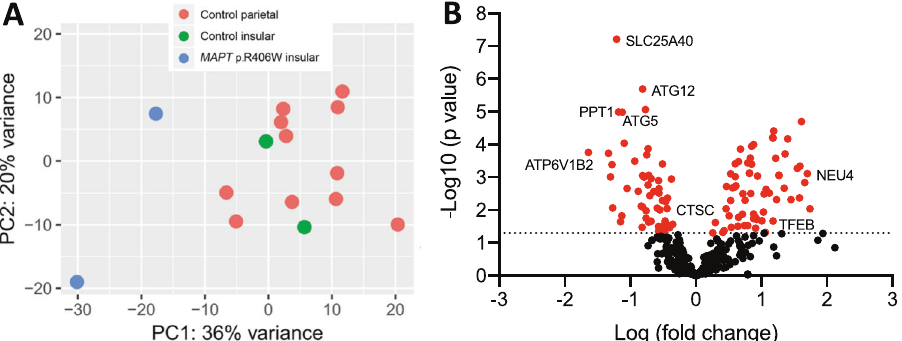
Fig. 1 TFEB-regulated genes are differentially expressed in MAPT p.R406W brains. RNAseq was performed in brains from MAPT p.R406W and neuropathology-free controls and reported in Jiang et al. [19]. A Principal component analysis reveals transcriptome-wide differences between MAPT p.R406W ( n = 2) and neuropathology-free control brains ( n = 16). B We tested whether genes that contain a CLEAR sequence or that are differentially expressed in the presence of TFEB in vitro were differentially expressed in human brains from MAPT p.R406W carriers compared with normal controls. Volcano plot showing log2 fold change between MAPT p.R406W and control brains and the – log 10 p -value for each gene. Red nodes: genes with p <